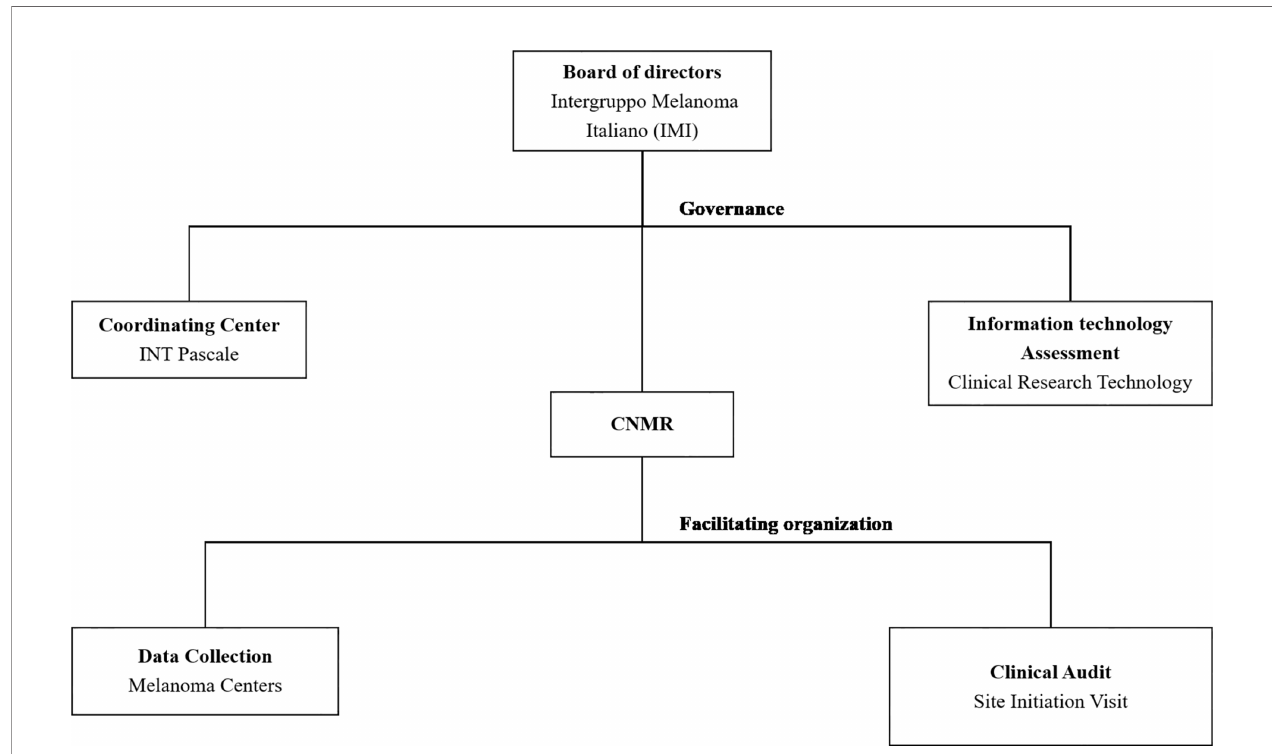
FIGURE 1 | Integrated management of CNMR. Two main complementary approaches are considered — Governance and Facilitating